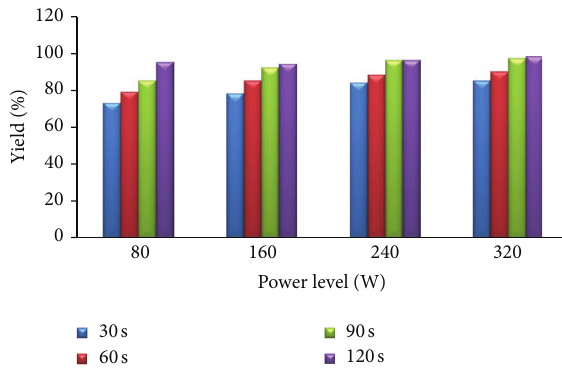
Figure 3: Power level versus yield (%) for the preparation of the compound (2c) under MWI